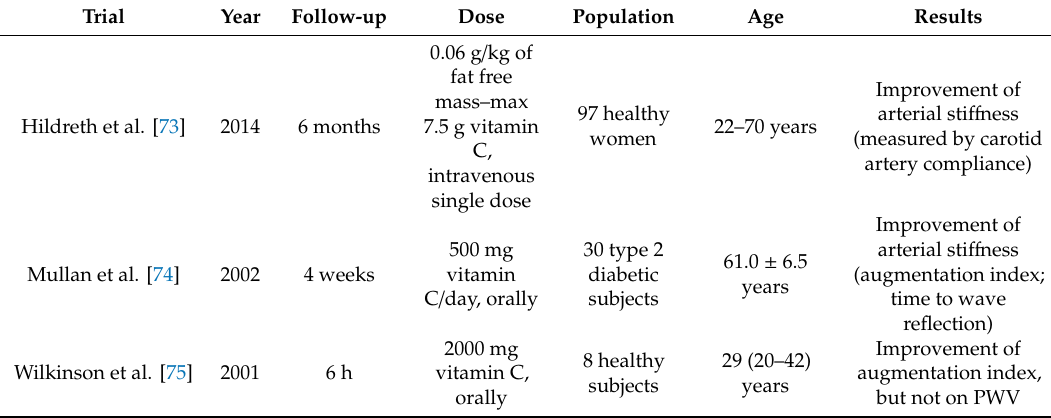
E ff ects of vitamin C supplementation on asymptomatic CVD subjects and subclinical